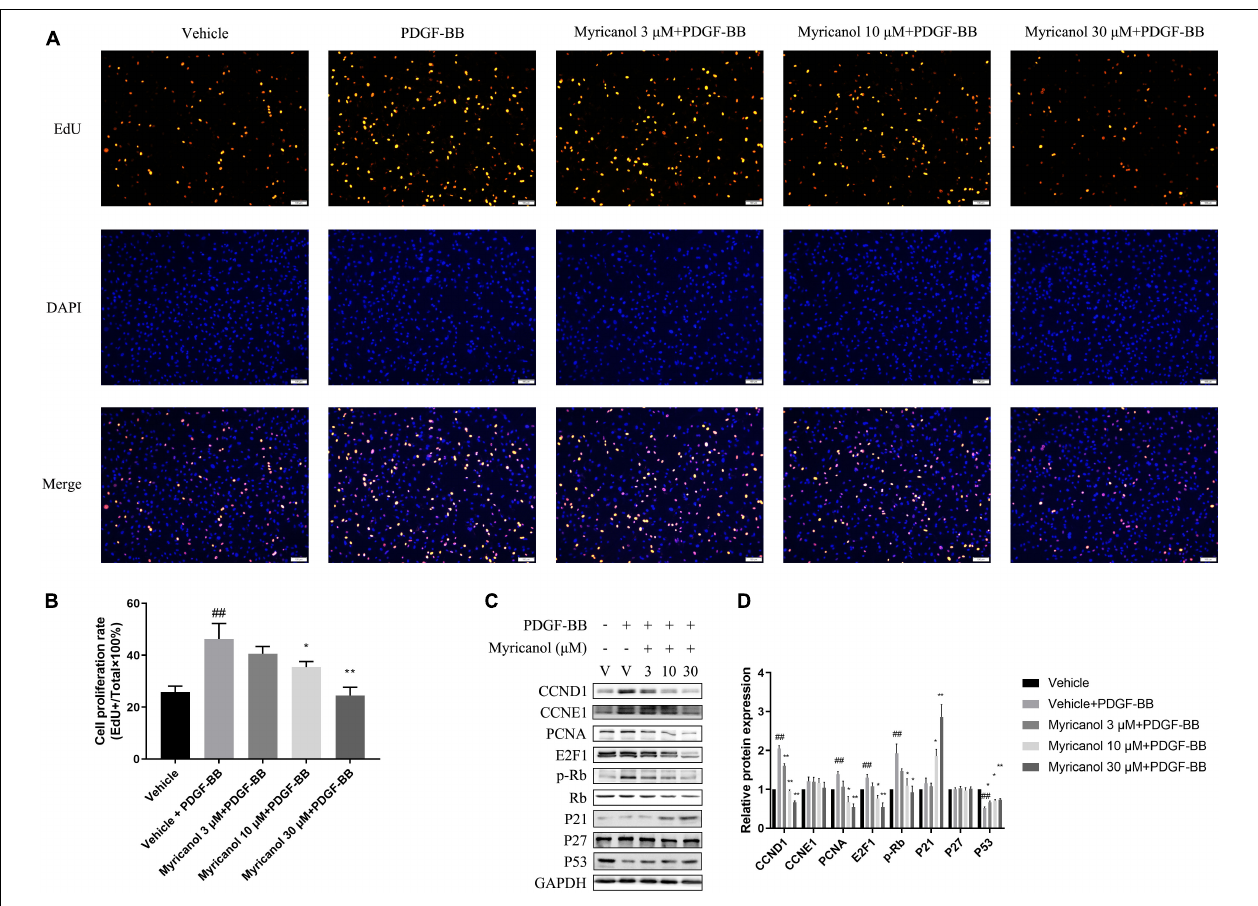
FIGURE 1 | Myricanol inhibits PDGF-BB induced VSMCs proliferation. (A) VSMCs were stained with EdU (red) and DAPI (blue). Scale bar, 100 µ m. (B) Quantification of the proliferative cells (normalized to vehicle). Data are represented as mean ± SEM ( n = 3). ## P < 0.01 vs. the Vehicle group. * P < 0.05, ** P < 0.01 vs. the Vehicle + PDGF-BB group. (C) After being pretreated with indicated concentrations of myricanol or vehicle for 30 min, the cells were stimulated by PDGF-BB (30 ng/ml) for 24 h. The protein level of CCND1, CCNE1, PCNA, E2F1, P21, P27, P53, Rb, and Phosphorylated Rb were determined by Western blot analysis. (D) Quantification of the Western blot analysis. Data are represented as mean ± SEM ( n = 3). ## P < 0.01 vs. the Vehicle group. * P < 0.05, ** P < 0.01 vs. the Vehicle + PDGF-BB